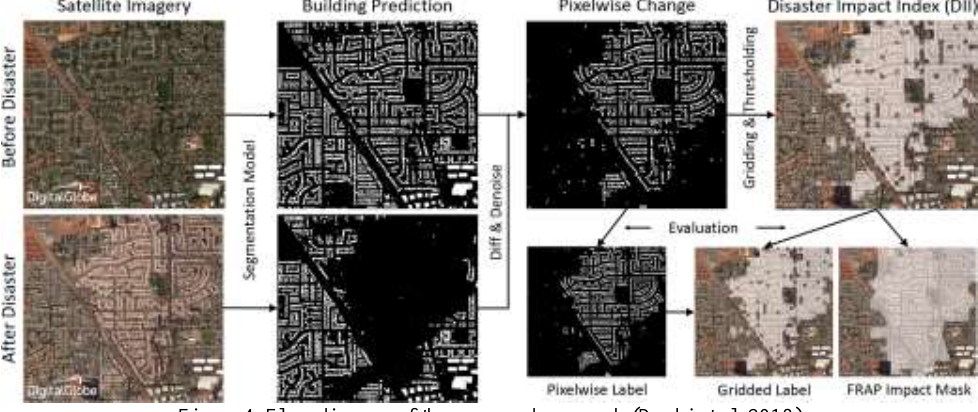
Figure 4. Flow diagram of the proposed approach (Doshi et al.